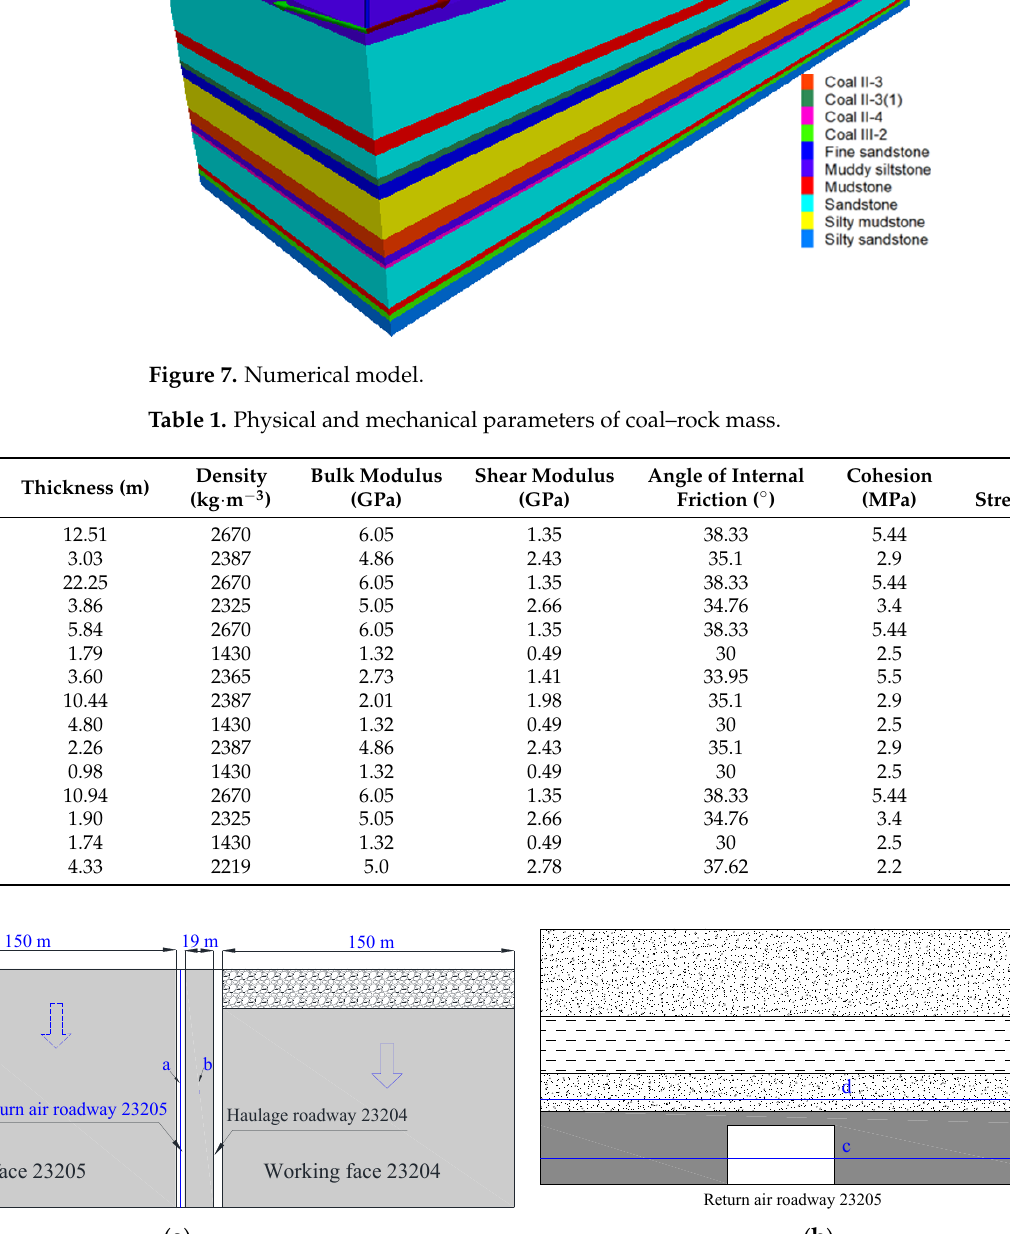
Figure 7. Numerical model. Table 1. Physical and mechanical parameters of coal–rock mass .